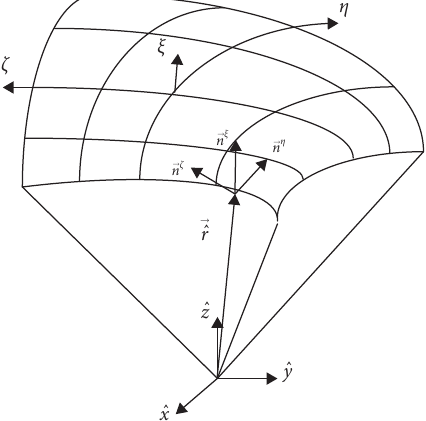
Figure 2: Transformation of global Cartesian coordinates to scaled boundary